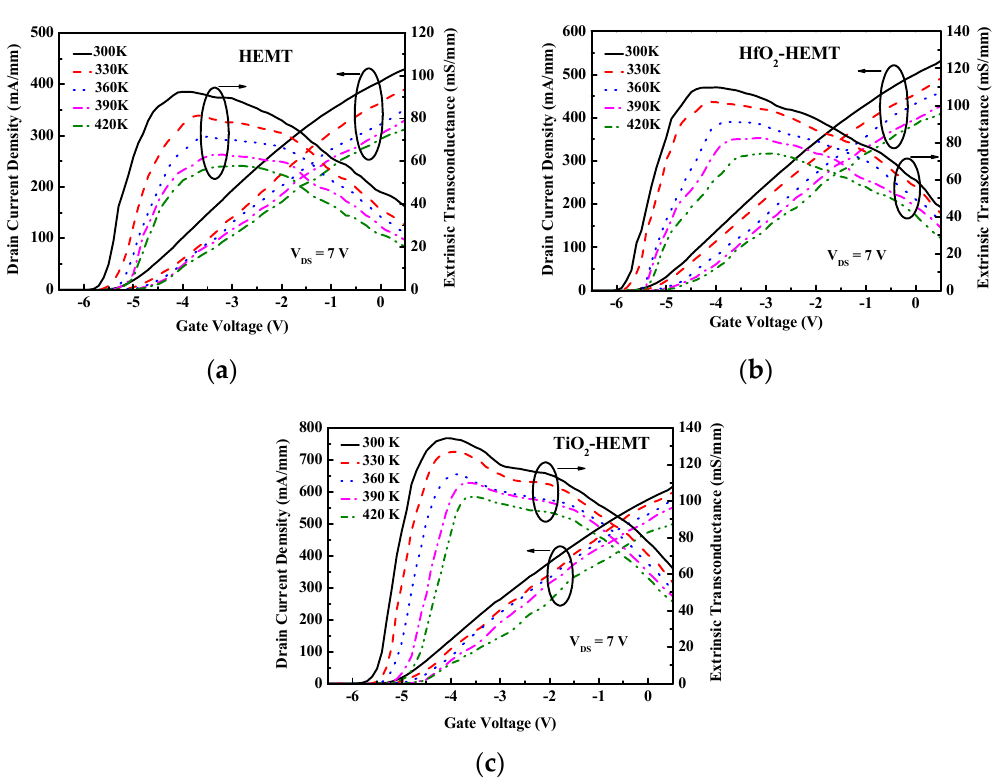
Figure 3. Family of drain-source output curves of ( a ) HEMT, ( b ) HfO 2 -HEMT, and ( c ) TiO 2 -HEMT at various temperatures. Figure 5b plots the maximum extrinsic transconductance ( g m,max ) versus temperature of the investigated HEMTs. When the temperature is increased, the maximum extrinsic transconductance varies in the same tendency as I DSS . At 420 K, the g m,max values for HEMT, HfO 2 -HEMT, and TiO 2 -HEMT are 56.3, 69, and 105 mS/mm, respectively. Experimental results demonstrate the TiO 2 -HEMT perform well even at high temperatures.